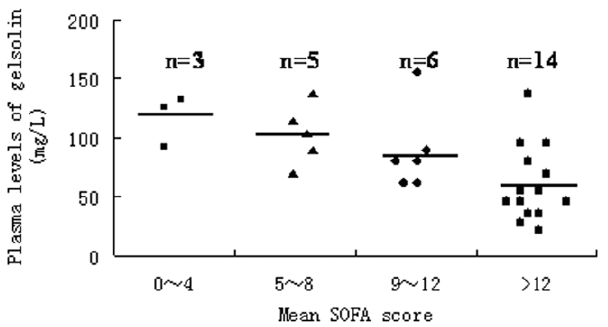
Figure 3. The relationship between pGSN levels and SOFA scores in patients with MODS. It was a comparision of the mean plasma gelsolin levels in 28 patients with different SOFA scores. The mean pGSN level in the . 12 SOFA score group was 57.6 6 27.7 mg/L, which was significantly lower than those in other three groups (the 0–4 SOFA score group: 122.3 6 80.3 mg/L; the 5–8 SOFA score group: 101.5 6 52.7 mg/L; the 9–12 SOFA score group: 92.4 6 47.5 mg/L, all P ,